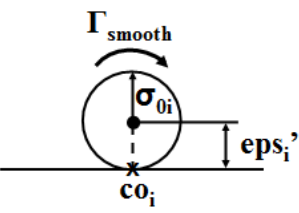
Figure 2. Shedding of a vortex blob during one time stepping ( co i is the pivotal point and eps i ’ defines the “smooth shedding point” location of the vortex blob).